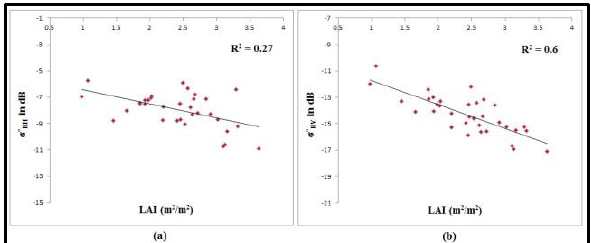
Figure 2. σ° RH and σ° RV values in dB at an incidence angle 32° versus LAI of paddy on 16 August 2015 and 10 September